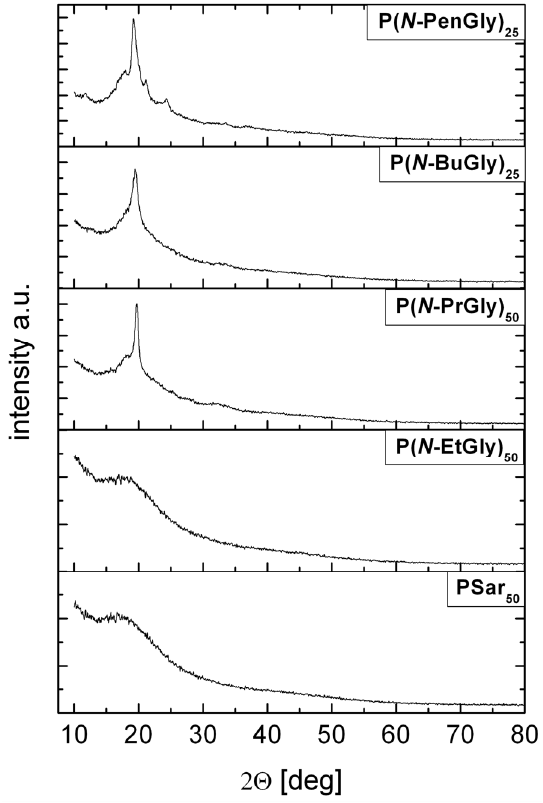
Figure 7. Powder XRD diffractograms of some synthesized